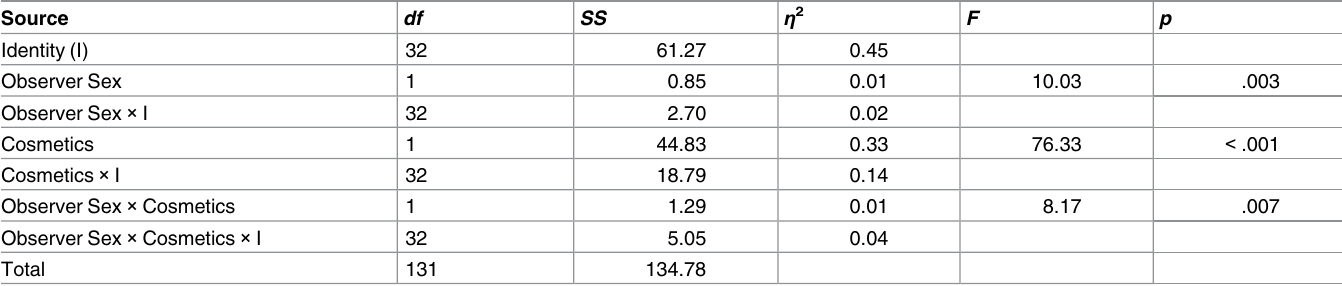
Table 1. Results of the analysis of variancefrom Study